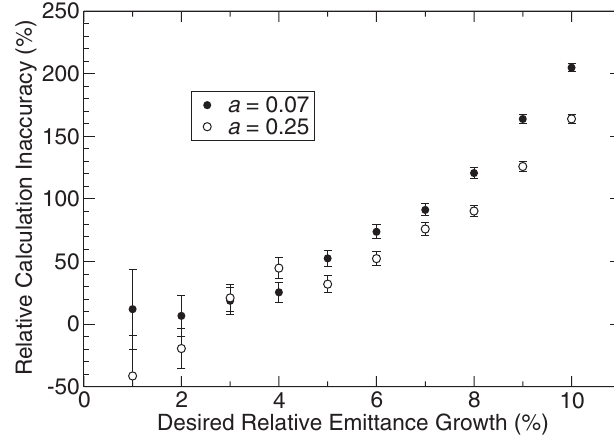
FIG. 11. Relative inaccuracy in the calculation of (cid:1) J vs the desired value of (cid:1) J=J , for the boundary distortion with the amplitude-dependent linear transformation. Different curves are for different values of a , uniformly spaced from 0.05 to 0.25.